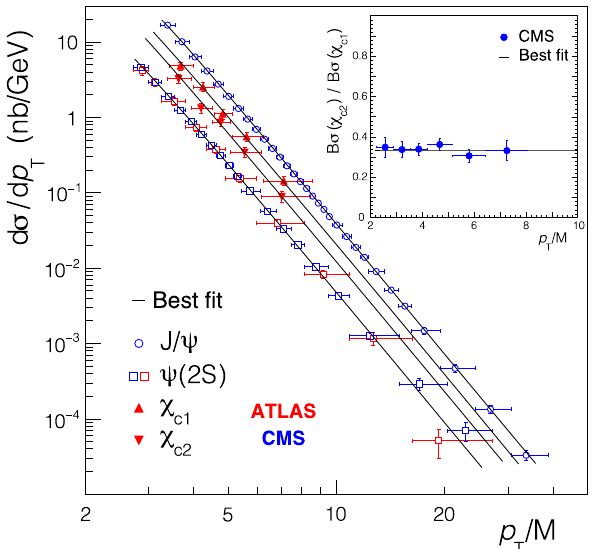
Fig. 1 Mid-rapidity prompt quarkonium cross sections measured in √ s = 7TeV by ATLAS (red markers) [8,25] and CMS pp collisions at (blue markers) [10]. The inset shows the χ c 2 to χ c 1 cross section ratio [26]. The curves represent the result of the fit described in the